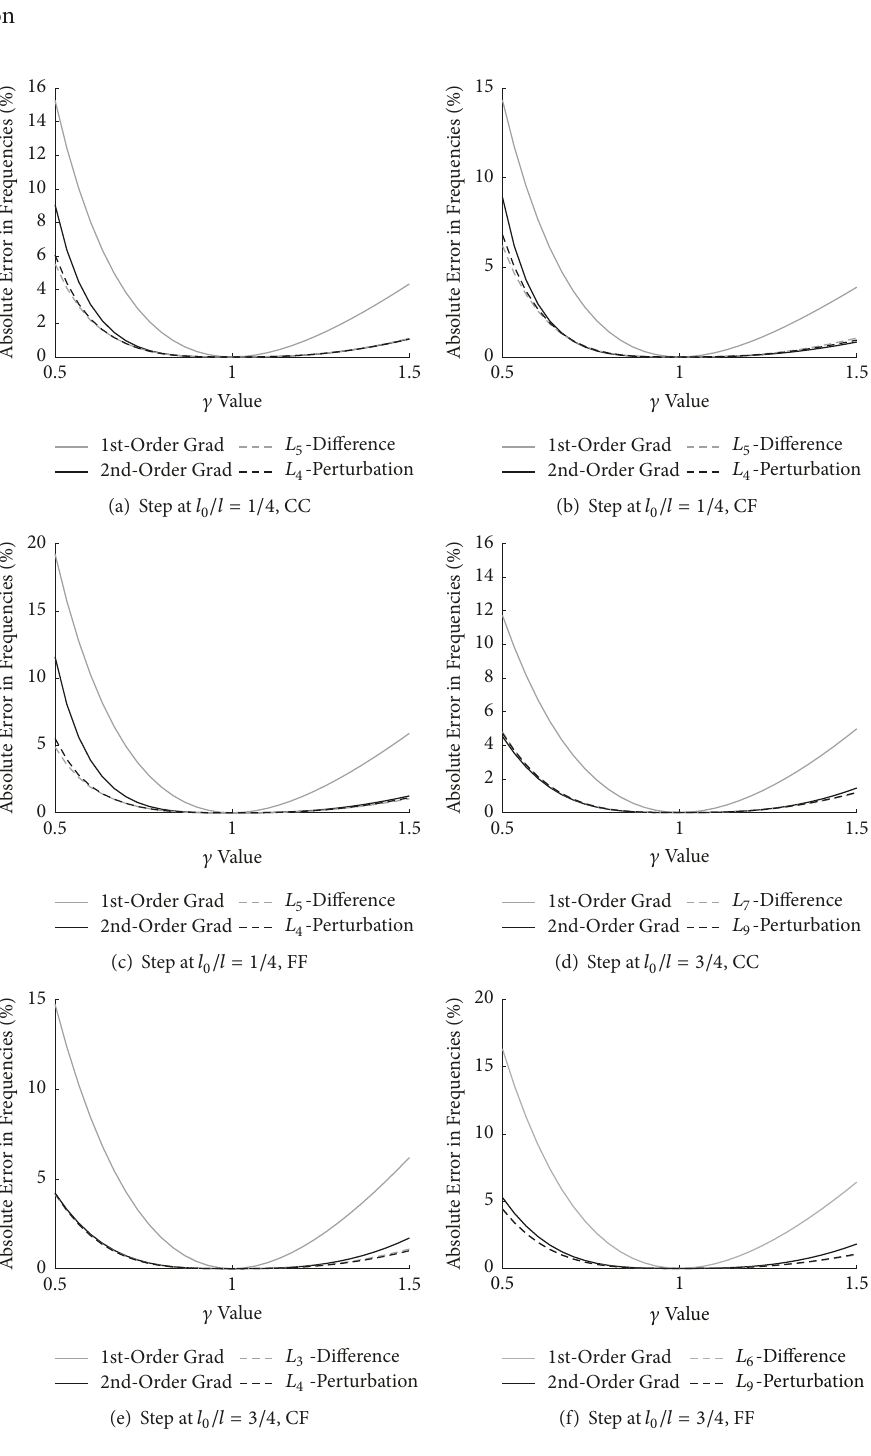
Figure 3: Frequency error results for variable 𝛾